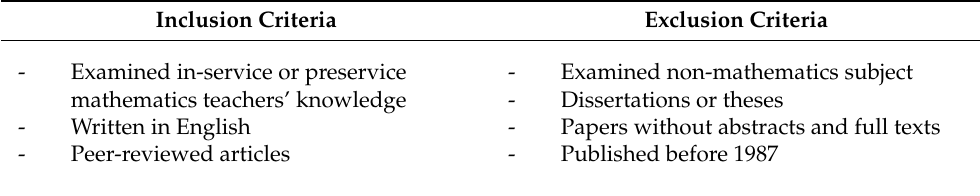
Table 2. Inclusion and exclusion criteria for data